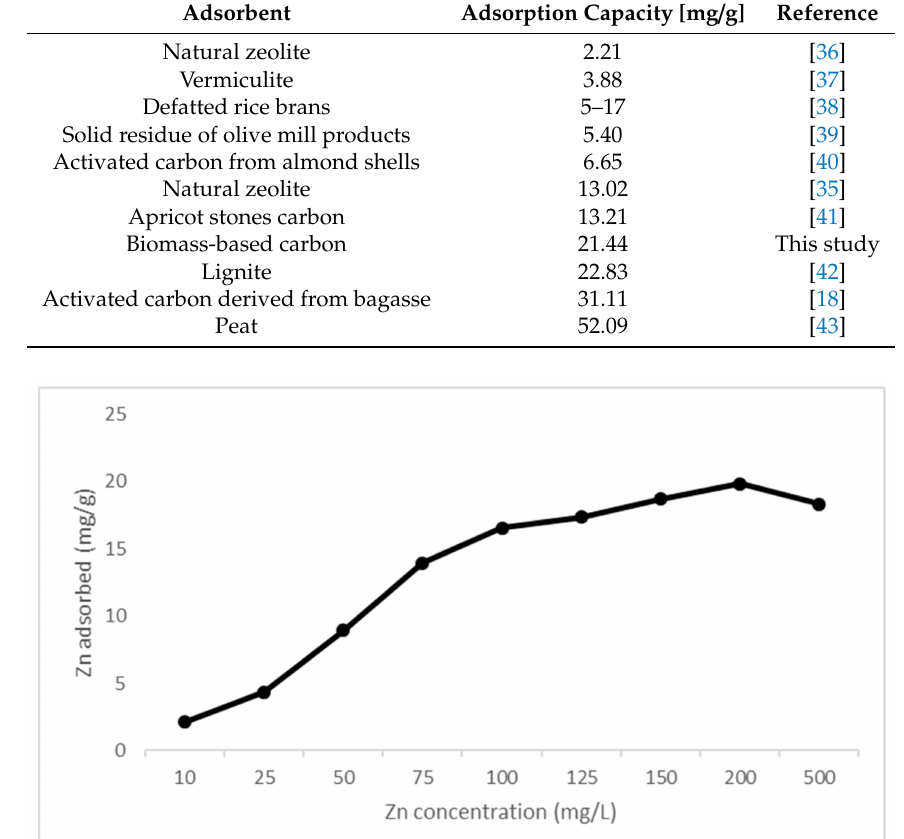
Table 2. Adsorption capacities of zinc (Zn) on various adsorbents.